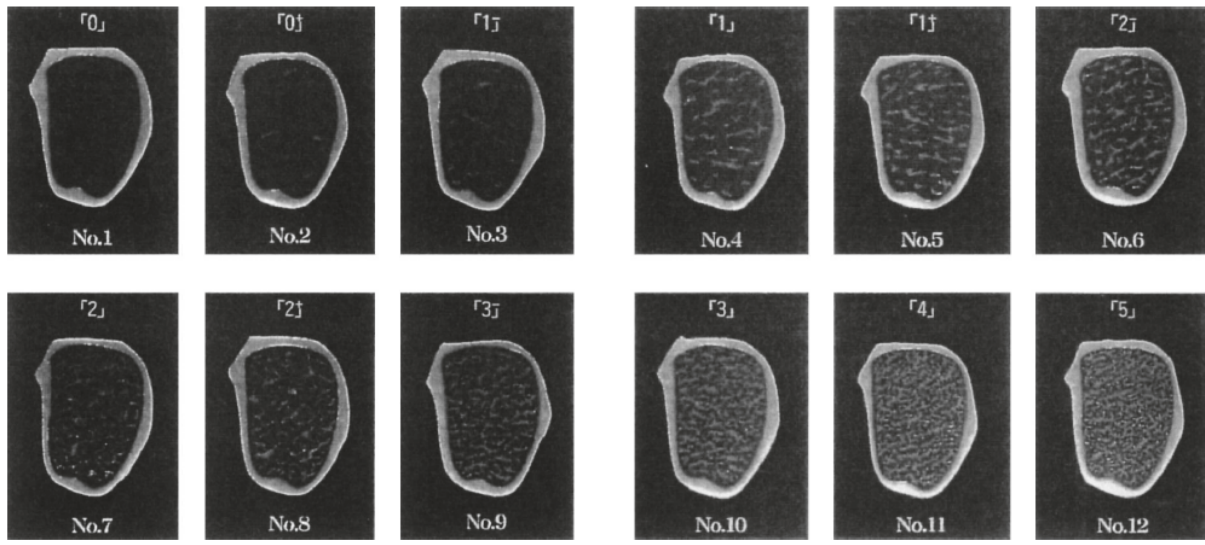
Figure 1: Beef quality levels based on marbling scores